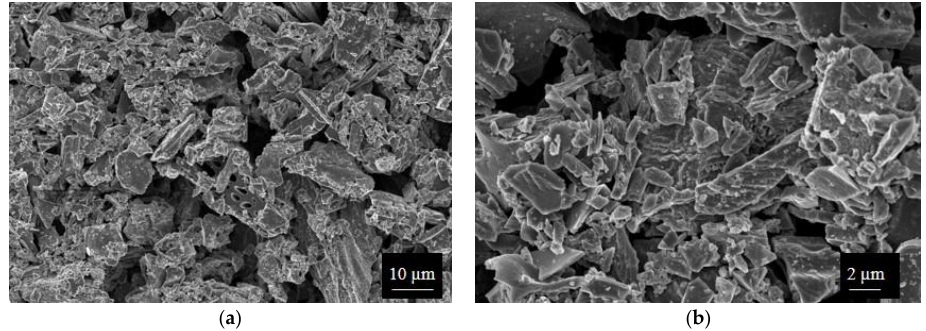
Figure 7. FESEM micrographs of SWP700 biochar sensor at different magnifications: ( a ) 2500×; ( b ) 10,000×.